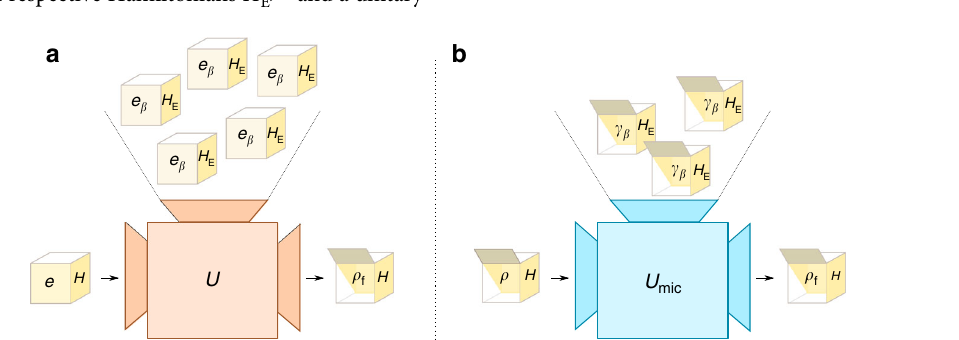
Fig. 1 Pictorical representation of the equivalence between macrostate operations and microstate operations. Panel a shows macrostate operations and b microstate operation. Closed boxes represent systems from which we only know some partial information, in this case the mean energy. Inside the box there is the actual microstate unknown to us if the box is closed. Scenario a shows the situation where one has an initial system of which only the mean energy e is known and one can use any environment, being again limited to knowledge of its initial average energy e β . The question is whether we can fi nd a unitary U that takes the two systems, regardless of what is actually inside of them, to one box for which we are certain that we will fi nd inside the microstate ρ f . The answer to this question is provided by scenario b , where the initial boxes of system and environment are both open (implying that we know what is the microstate) and populated with the maximum-entropy ensemble. U exists if and only if there exists a unitary U mic that implements the transition in b when taking ρ = γ e ( H ). This shows that a thermodynamic transition is possible if and only if it is also possible under the assignment of ensembles to